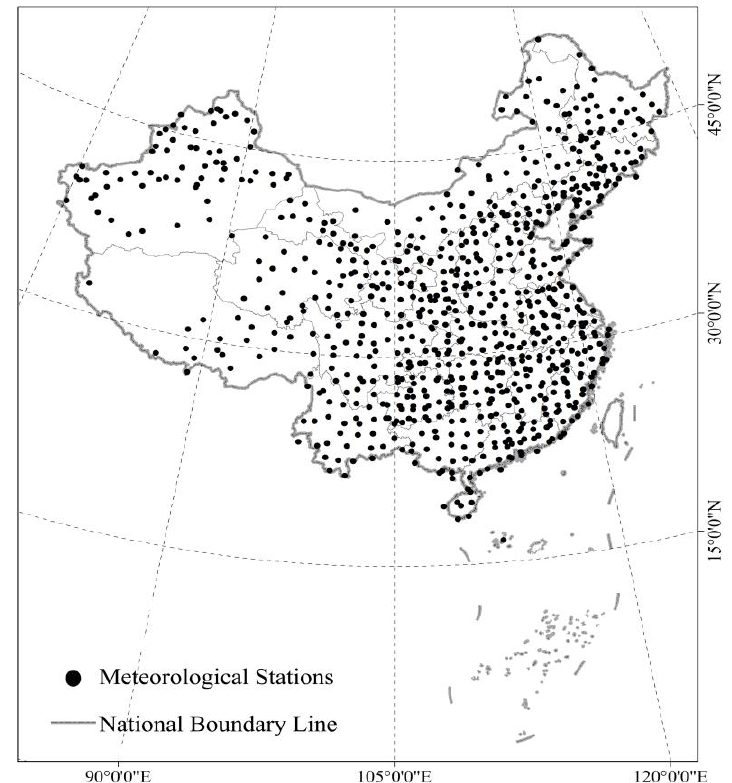
Figure 2. Distribution of weather stations over China.